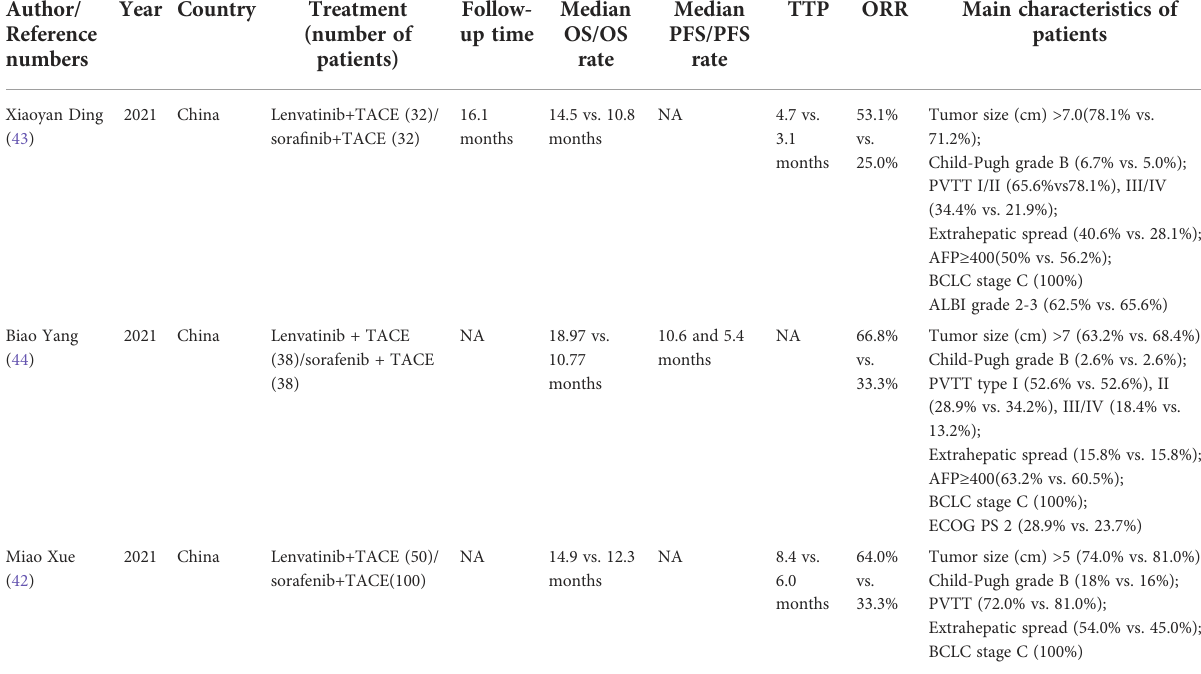
TABLE 2 Lenvatinib plus TACE therapy compared with sorafenib plus TACE